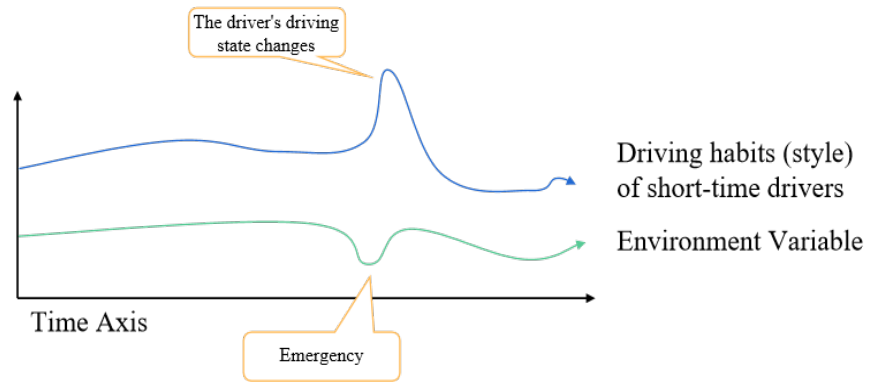
Figure 9. Environmental factors remain unchanged in the short term (explanatory diagram).